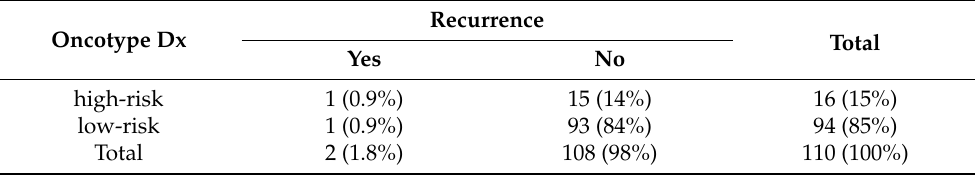
Table 5. Clinical performance of the Oncotype DX ® RS. Oncotype Dx